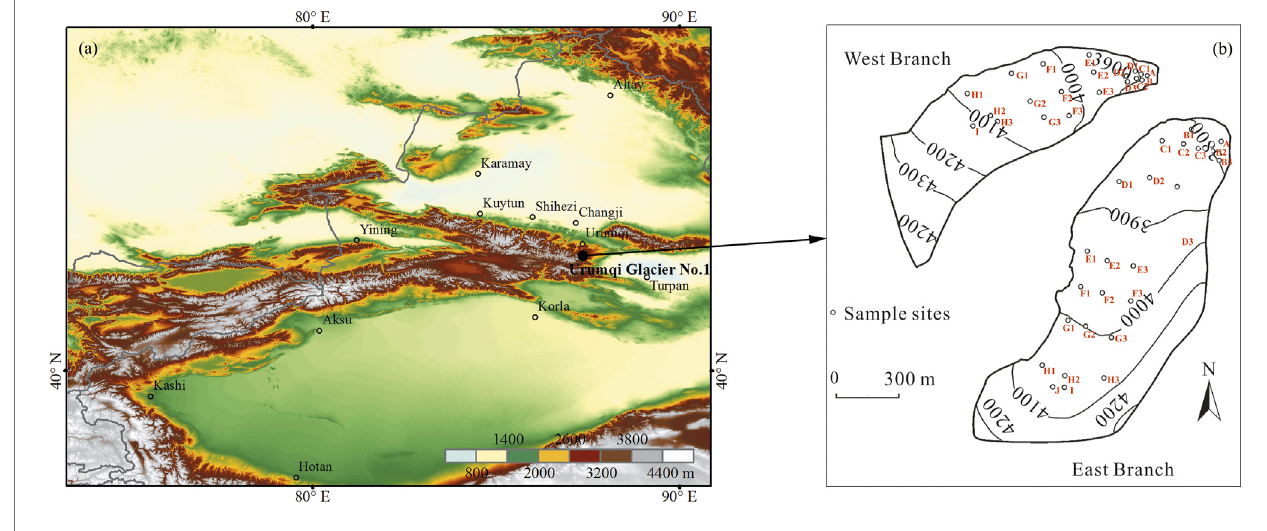
FIGURE 1 | Location and sampling sites on Urumqi Glacier No.1.